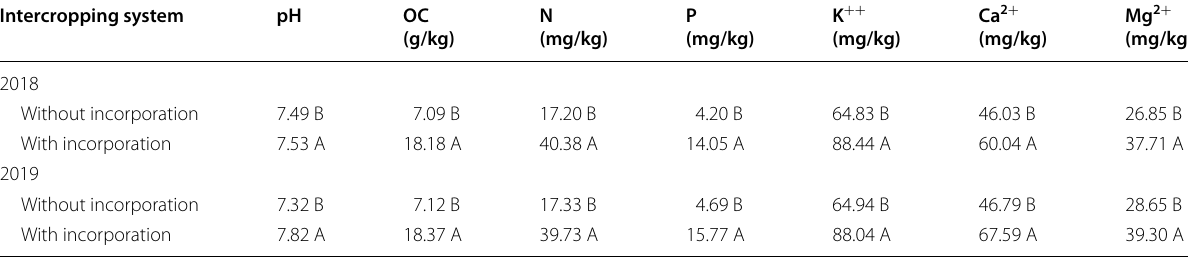
Table 5 Soil chemical characteristics with and without snap bean incorporation Intercropping system